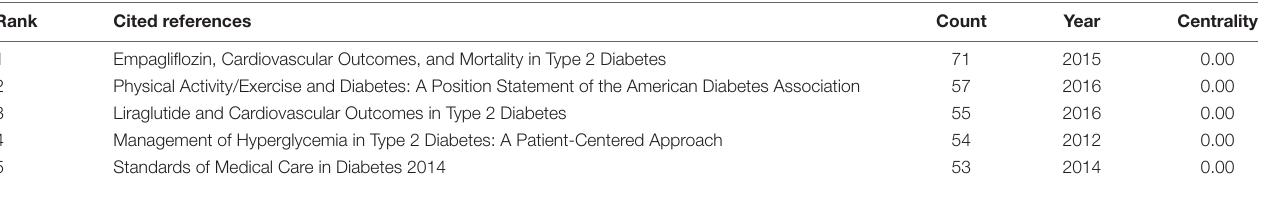
TABLE 6 | The top 5 prolific cited references in physical activity therapy for diabetes research.